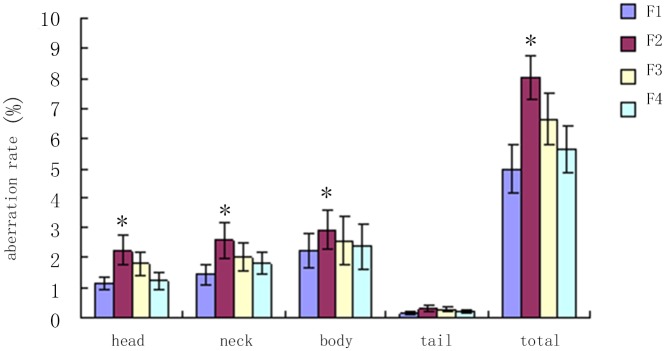
F1-F4 semen quality comparison.* compared with control group, P<0.05.